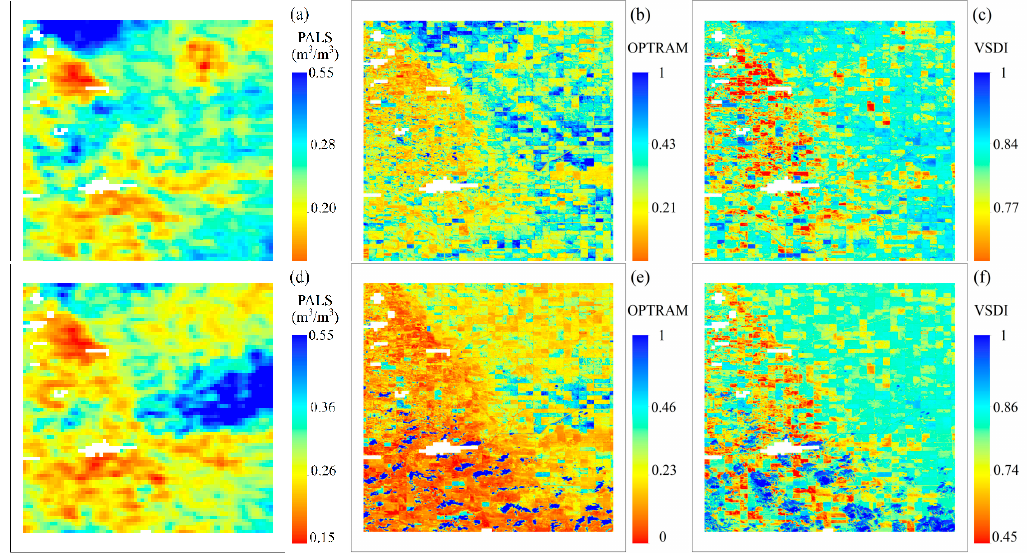
Figure 9. Spatial distribution of the aircraft SM, the OPTRAM and VSDI indexes on 11 June ( a – c ) and on 20 June ( d – f ), 2016 during the SMAPVEX16-Manitoba experiment.